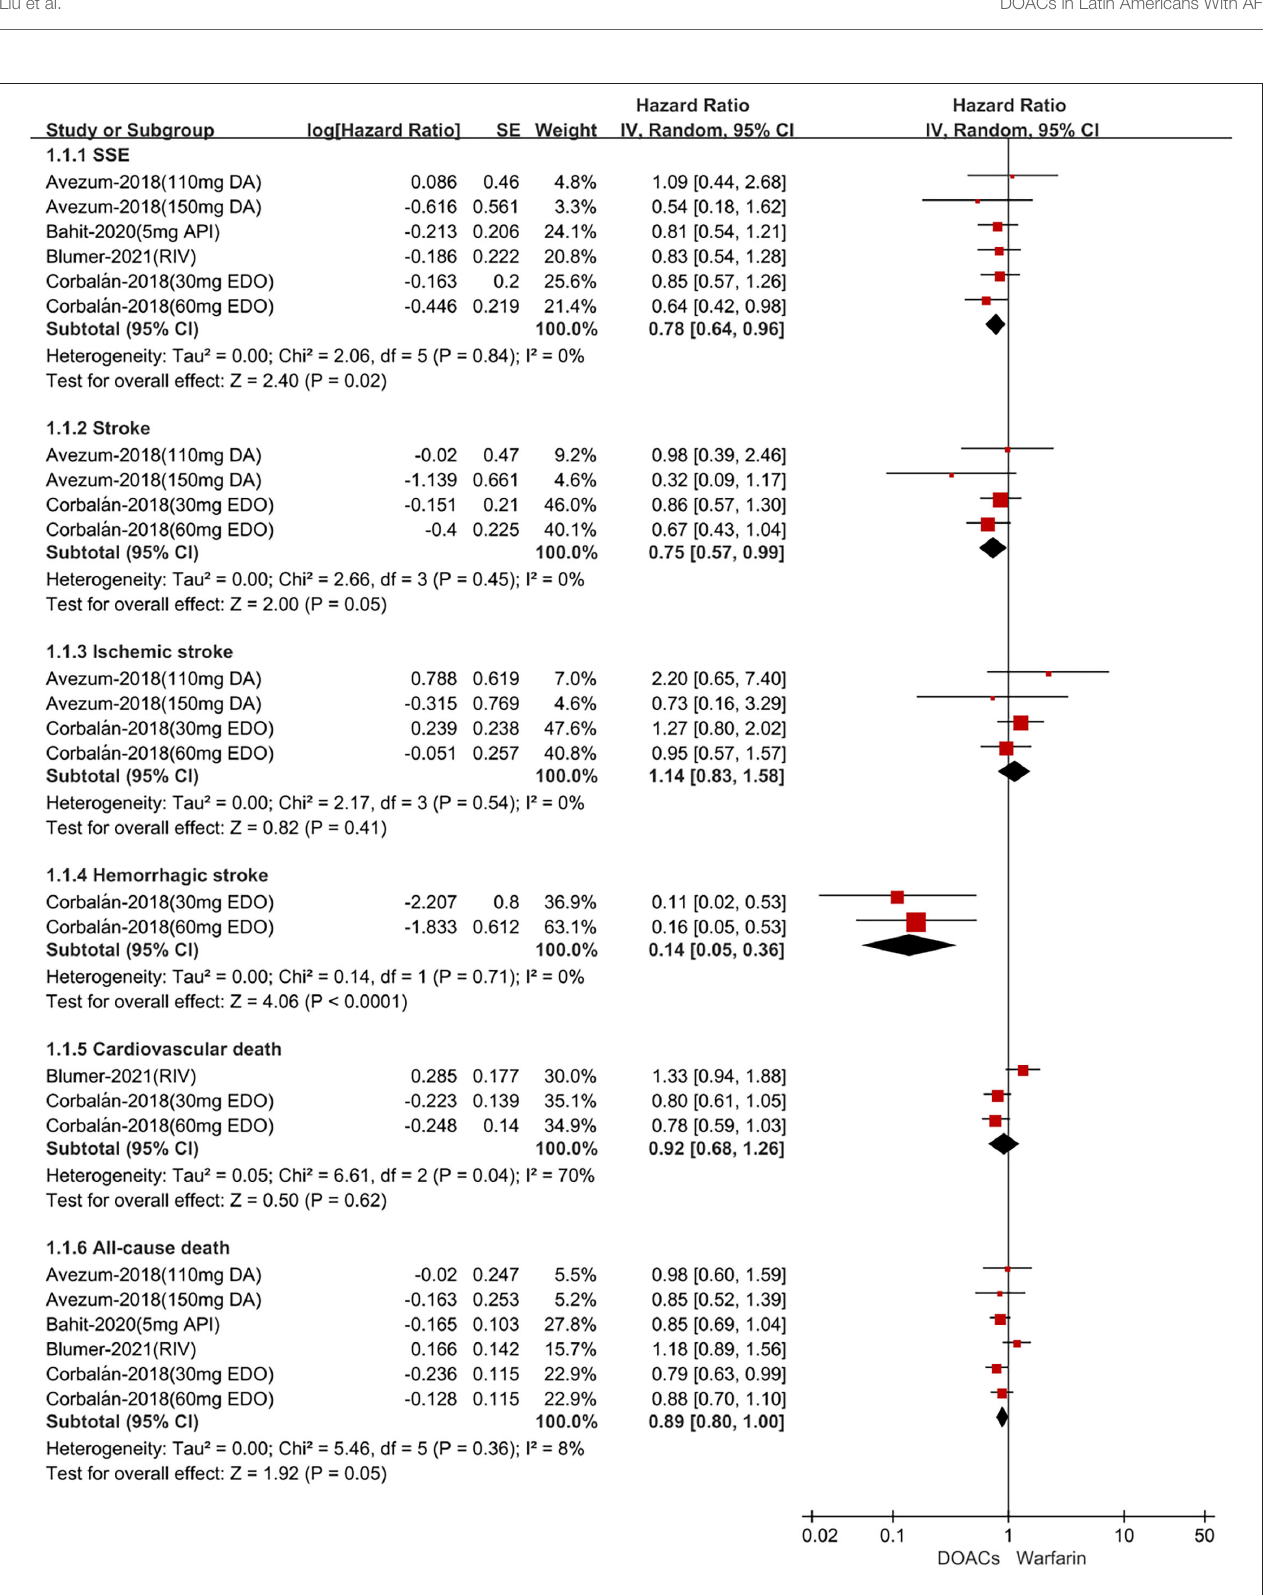
FIGURE 1 | Adjusted effectiveness date of direct oral anticoagulants compared with warfarin in Latin patients with atrial fibrillation. DOACs, direct oral anticoagulants; DA, dabigatran; API, apixaban; EDO, edoxaban; RIV, rivaroxaban; SSE, stroke or systemic embolism; CI, confidence interval.